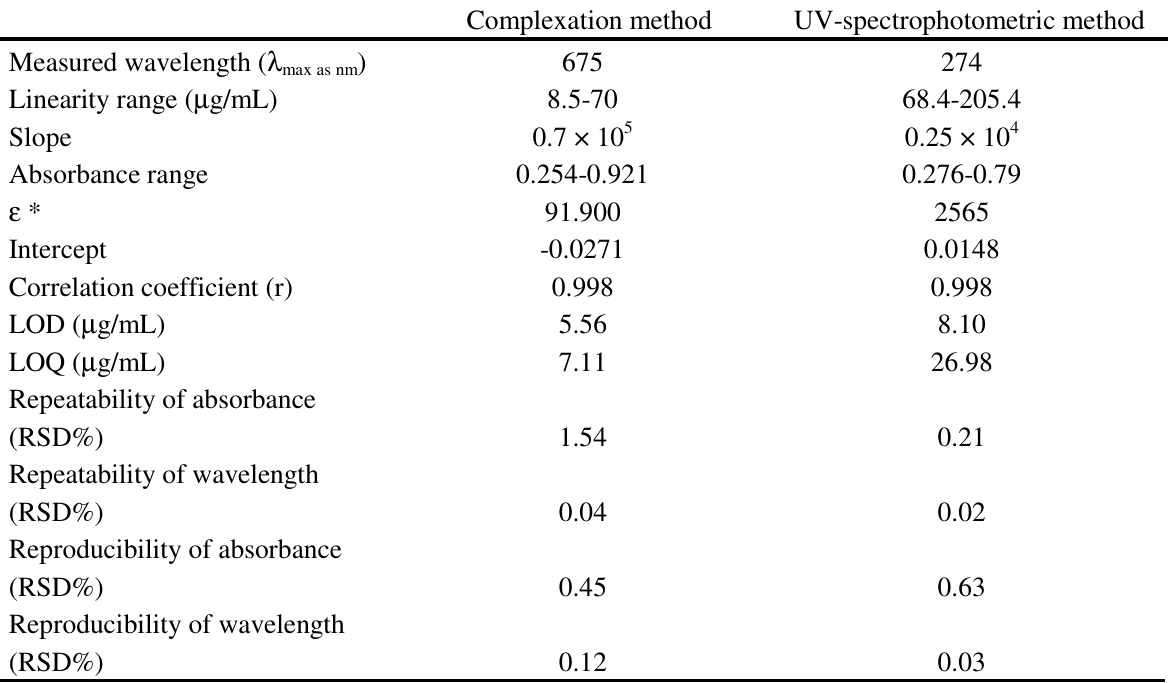
Table 1. Regression data of the calibration line for quantitative determination MPT by UV method.